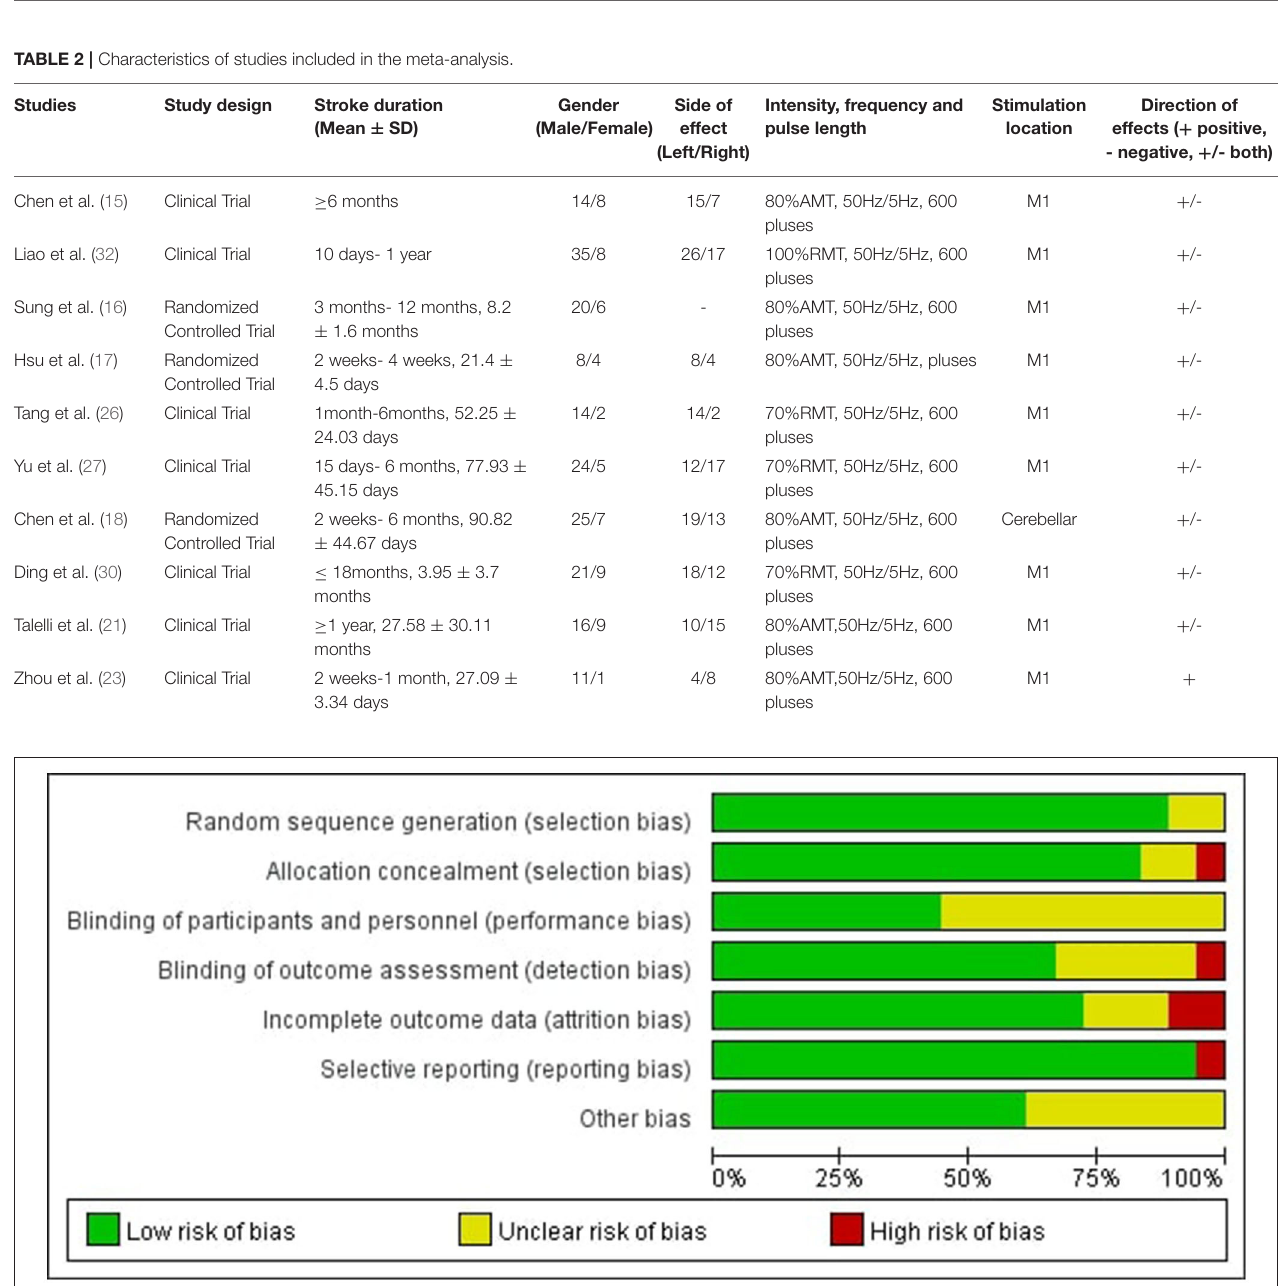
FIGURE 2 | Risk of bias